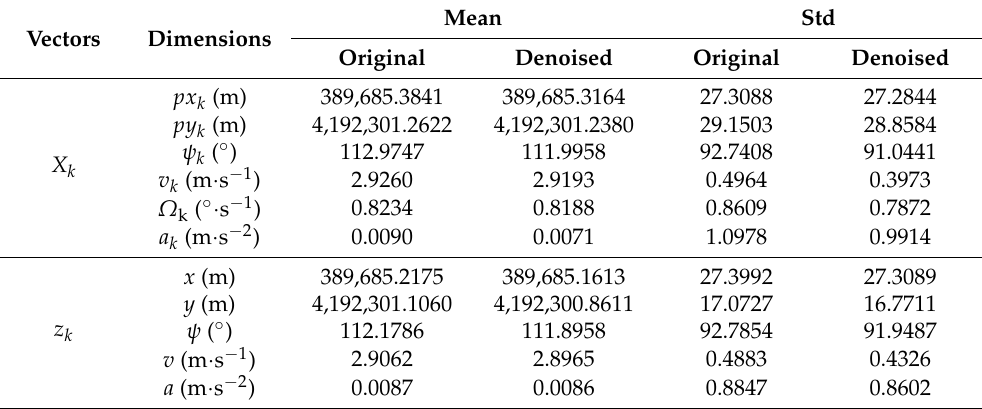
Table 1. Means and standard deviations of the original and optimized data for each dimension. Mean Vectors Dimensions